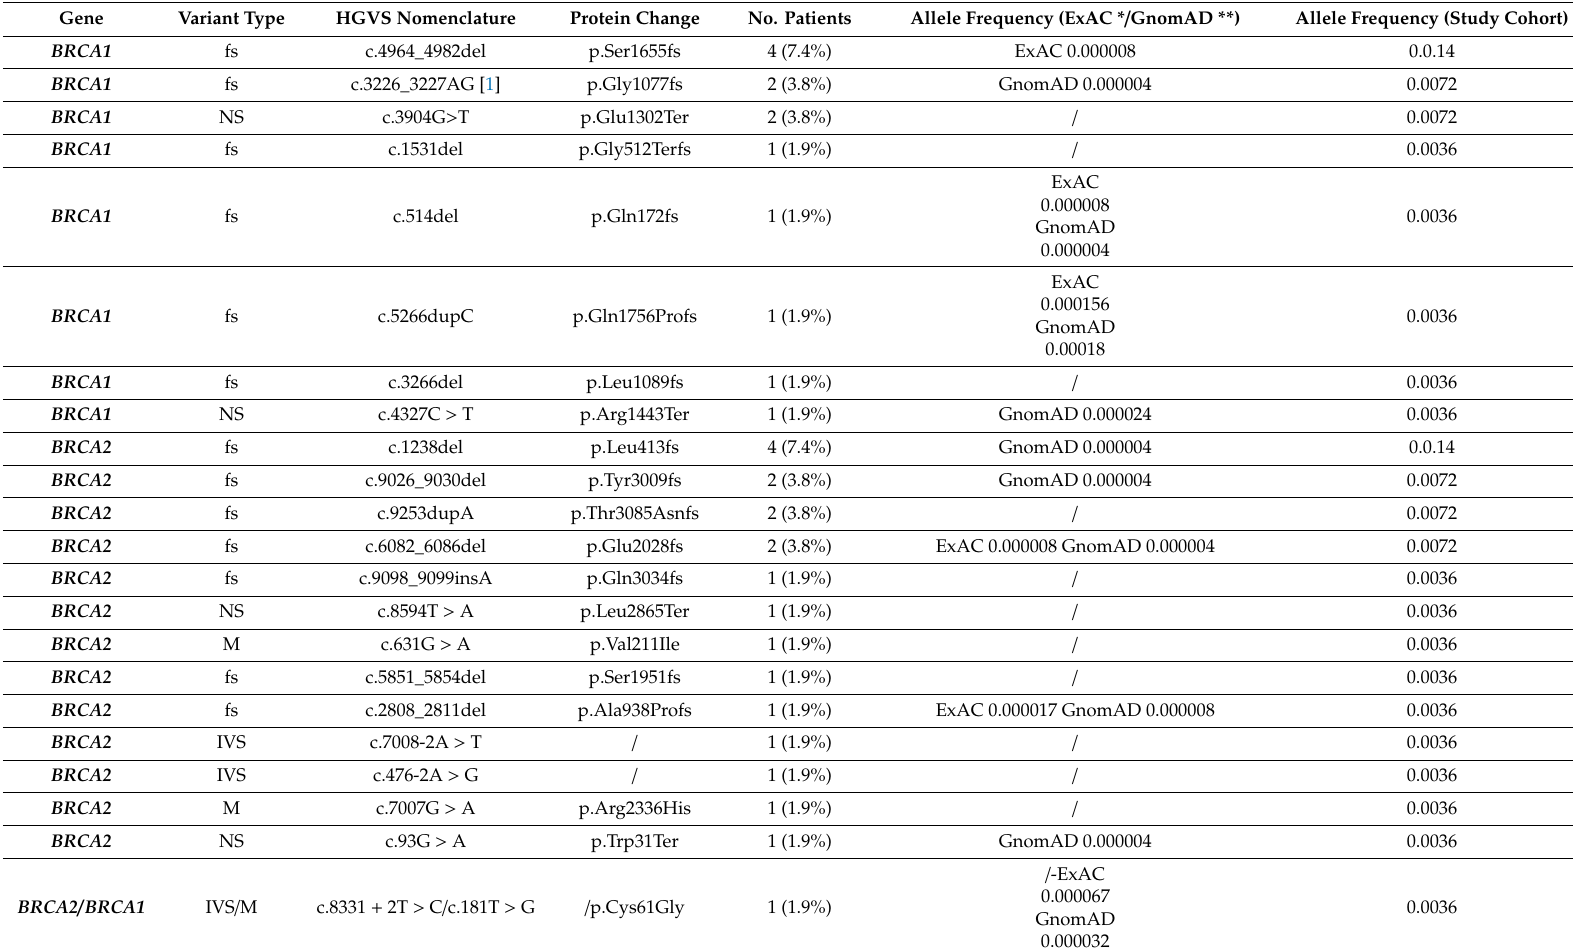
Table 2. BRCA1 / 2 pathogenic variants detected in patients with bilateral breast